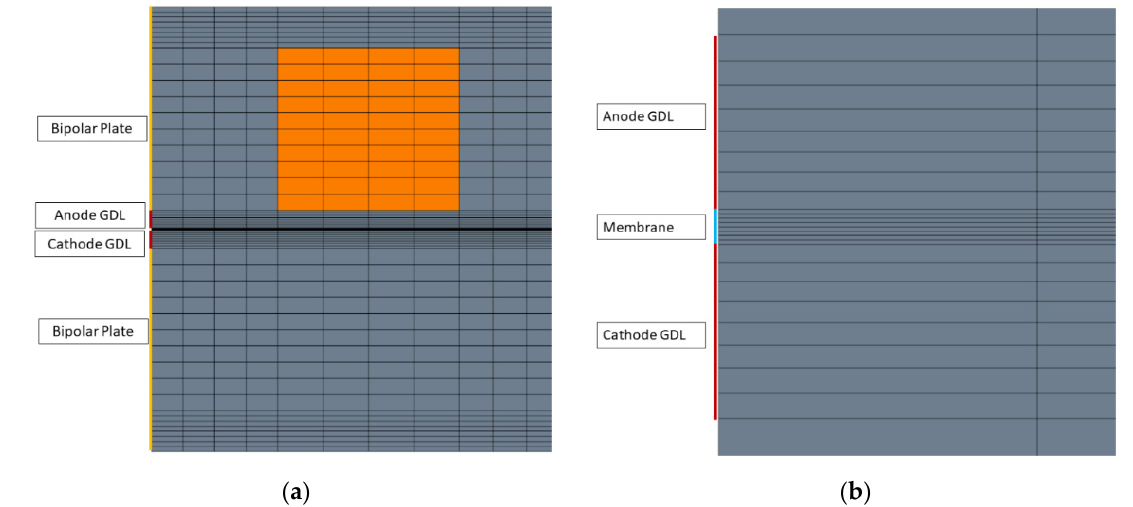
Figure 5. ( a ) Mesh distribution on the interface between bipolar plates and GDLs and ( b ) between GDLs and membrane.